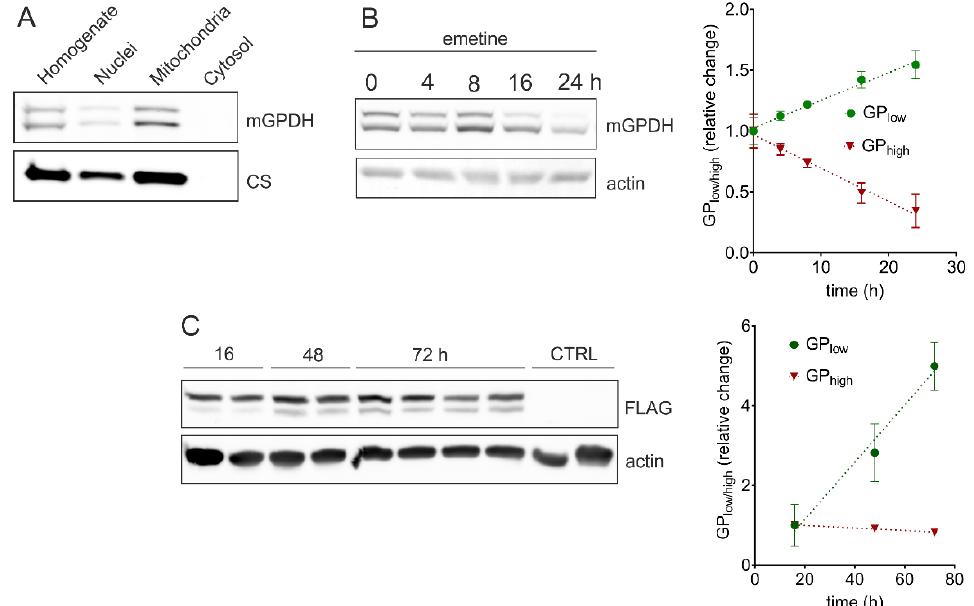
Figure 3. Western blot analyses of mGPDH processing and biogenesis. All samples were separated on SDS-PAGE and analyzed by Western blotting. ( A ) Lysates (30 μg protein) of different fractions of LNCaP cells were analyzed with specific antibodies against mGPDH and citrate synthase. SDS-PAGE and Western blot analysis of ( B ) cell lysates (30 μg protein) of LNCaP cells after inhibition of proteosynthesis by emetine (100 μg/mL) using a specific antibody against mGPDH and ( C ) cell lysates (20 μg protein) of HEK293 cells transiently transfected with a FLAG tag on C-term using a specific antibody against FLAG. Actin was used as a loading control. Quantified data represents a relative change of the GP low/high form of three independent experiments and is expressed as means ± S.D.